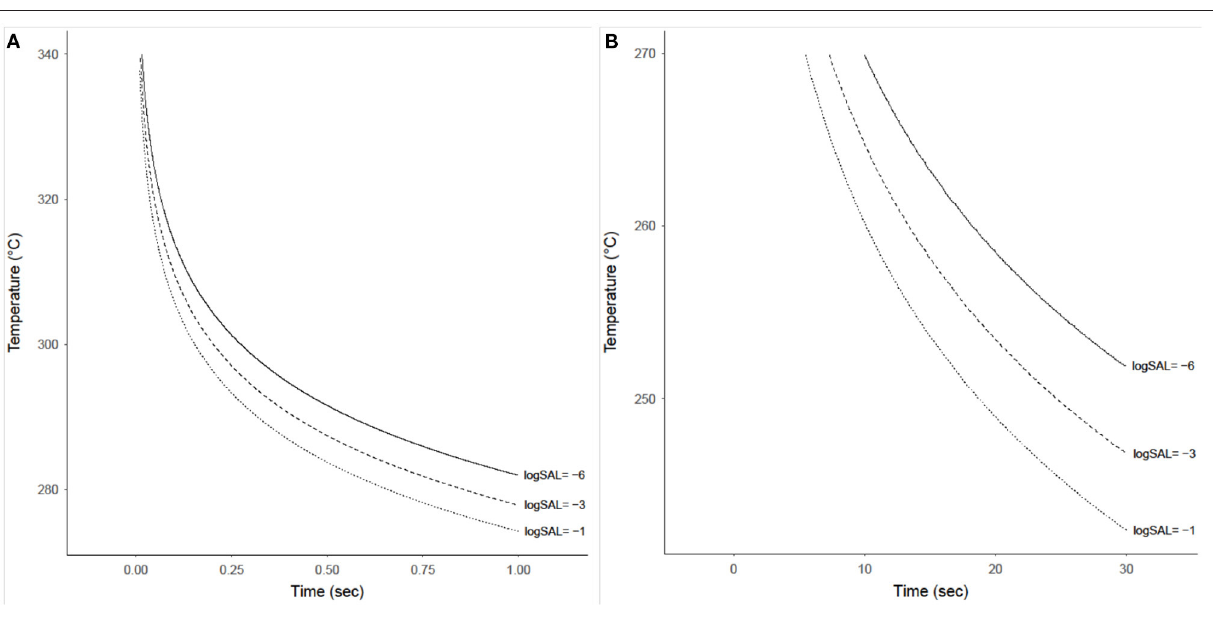
FIGURE 8 | Time-temperature contours achieving sterility assurance levels (SAL) of 10 − 1 ,10 − 3 , and 10 − 6 for a product with an initial bioburden of 1 × 10 6 prior to heat treatment. (A) Shows these contours for temperatures from 275 to 340 ◦ C and exposure times from 0.01 to 1 s. (B) Shows these contours for temperatures from 240 to 270 ◦ C and exposure times from 0.1 to 30 s, although these SAL contours only exist starting at ∼ 7